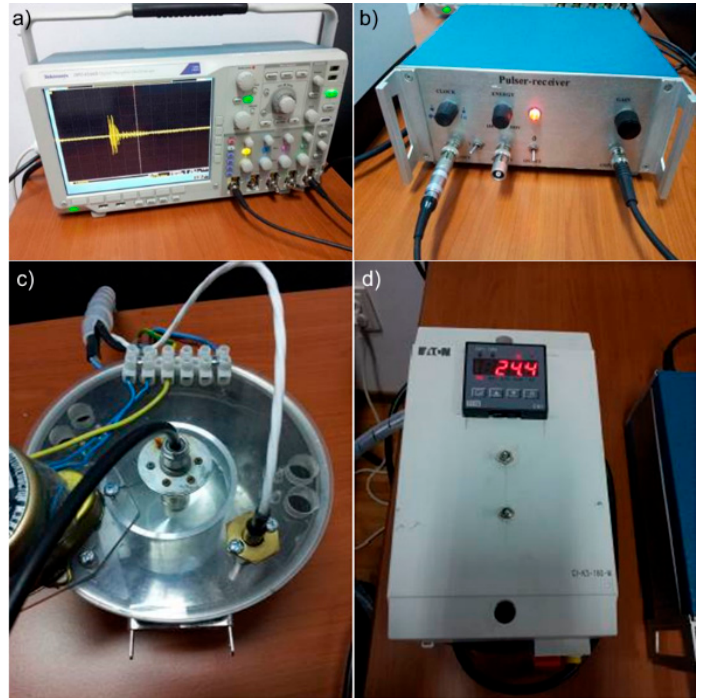
Figure 12. Experimental setup: Oscilloscope used to display and store the measured signals ( a ); pulser-receiver ( b ); thermo-controlled container ( c ) and the electronic control module ( d ).